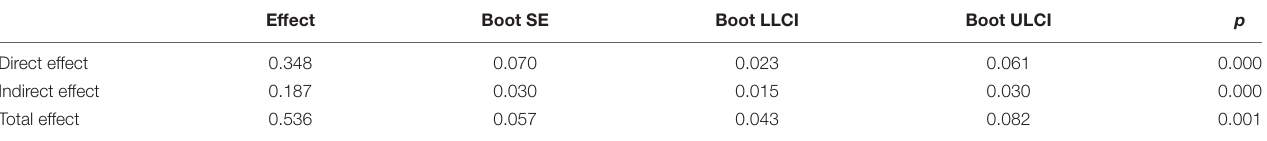
TABLE 11 | Results of neuroticism mediating effect between occupational strain and psychological